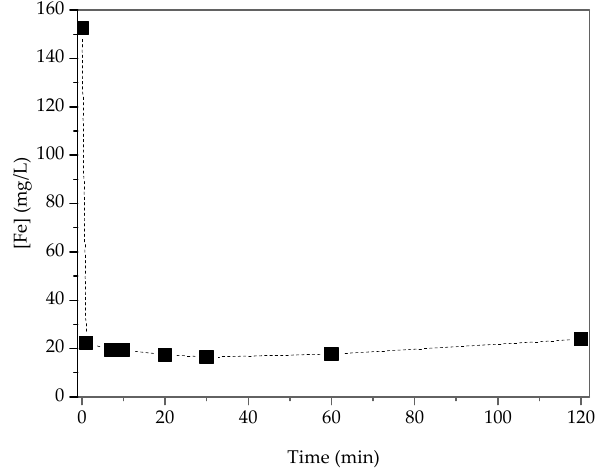
Figure 5. Behavior of iron during OMWs treatment by the photo-Fenton reaction. Operating conditions: Initial concentration of the H 2 O 2 solution used = 5.0% (w / v); pH = 3.0; T = 20 ◦ C; agitation rate